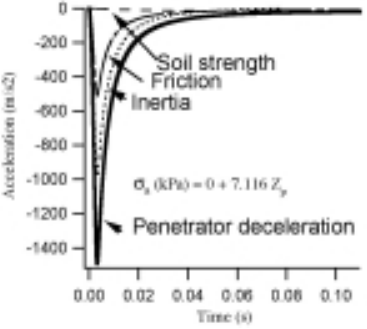
Fig. 3. Penetrator deceleration (negative acceleration) for an 8-kg penetrator with 30 ◦ cone half-angle and initial velocity of 15.2 m/s. Initial soil conditions are given in Table 1 and β = 0.016. The calculated total penetrator acceleration and the partition of the acceleration into the contributions from soil strength, friction between the penetrator and soil, and inertia associated with soil particle acceleration during soil compaction are shown in Fig. 3 for the case of β = 0.016. The table of calculated depth of penetration results and the associated final and fractional final densities (the fractional density is the ratio of final density to solid soil mineral density ( ρ f / ρ s ) for a range of β values from 0.26–0.016 are given in Table